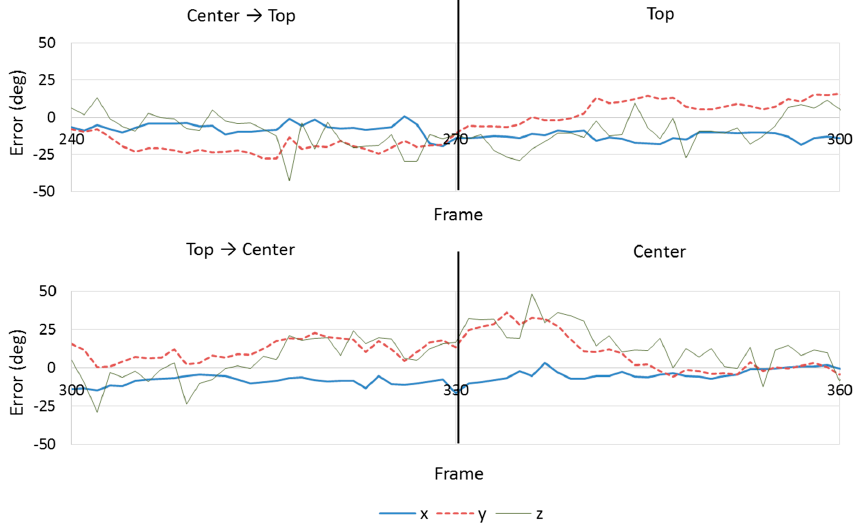
Figure 10. Translation errors when the head was moved vertically.